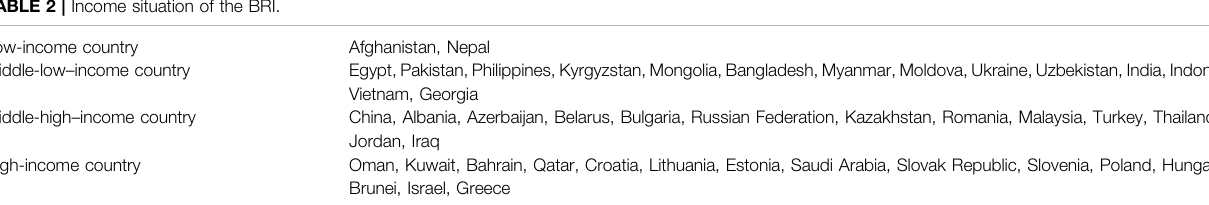
TABLE 2 | Income situation of the BRI.